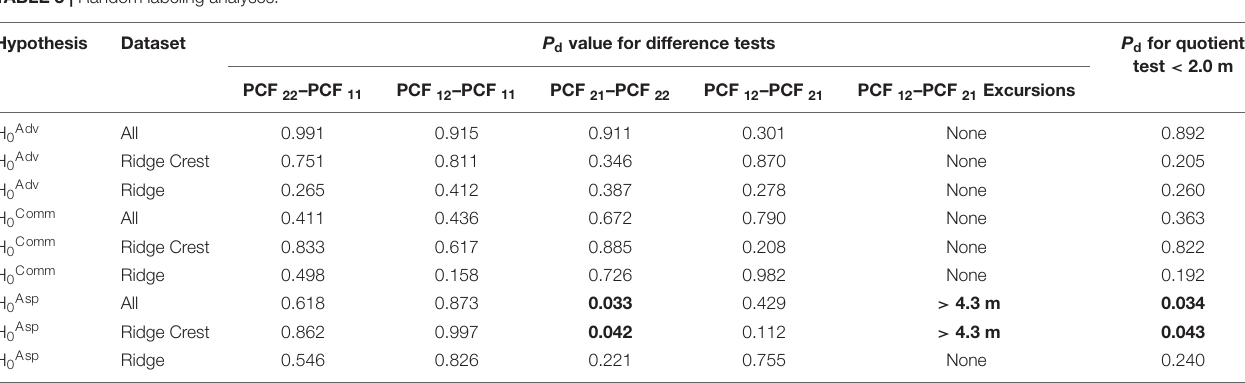
FIGURE 3 | Spatial maps. (A) All specimens identified, (B) Density map of the 2D project in square meters, and (C) the analyzed data. Shaded area of (C) in purple is the Ridge area and green is the Ridge Crest area. TABLE 3 | Random labeling